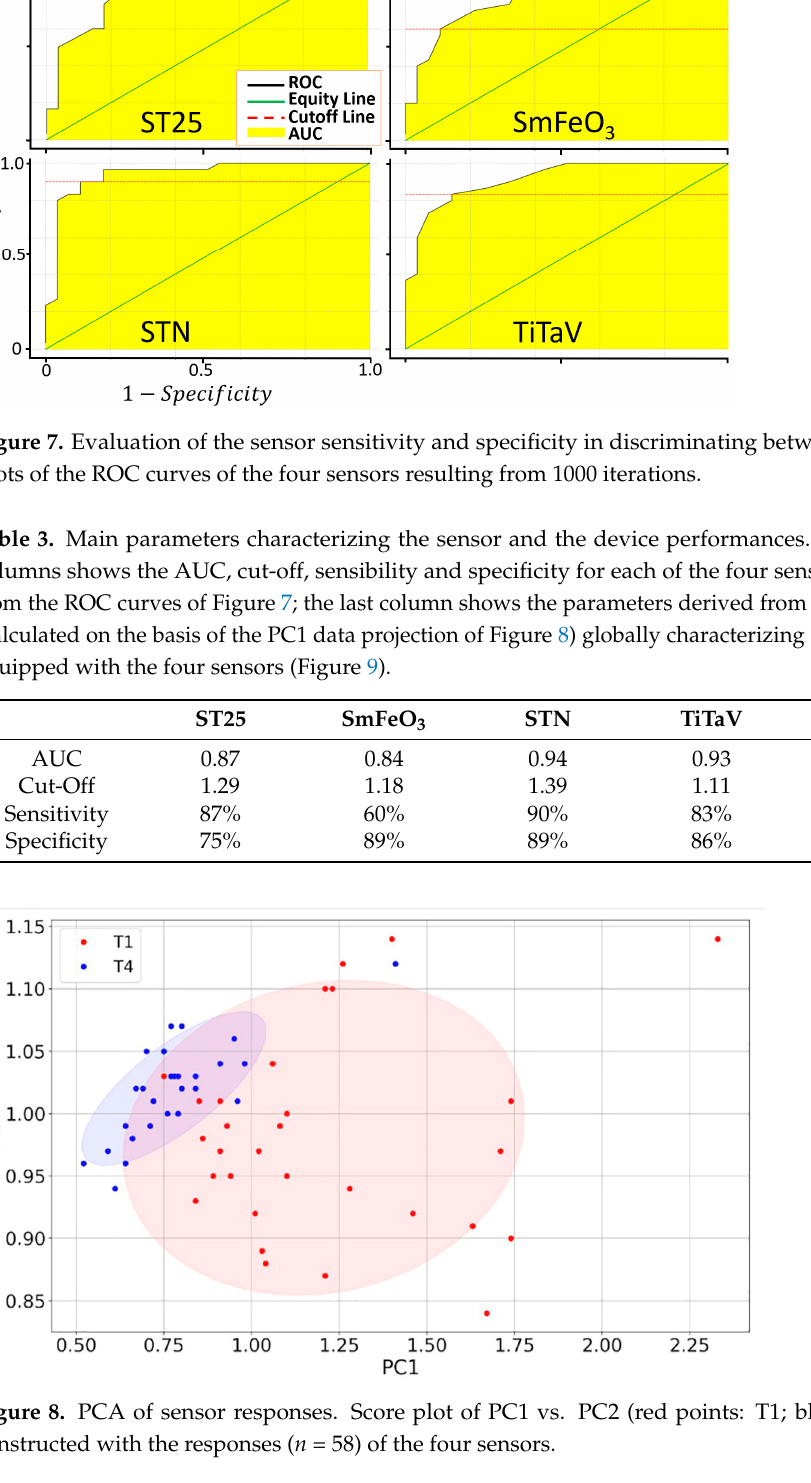
Figure 9. Evaluation of the sensitivity and specificity of the device in discriminating between T1 and T4 samples. ROC curve calculated on the PC1 projected dataset resulting from 1000 iterations. 3.3. Sensor Discrimination Power To better assess the discriminating power between T1 and T4 of the four sensors, their responses were further analyzed with the Principal Component Analysis (PCA) [59]. The four eigenvectors of the covariance matrix (PC1, PC2, PC3, PC4), calculated starting